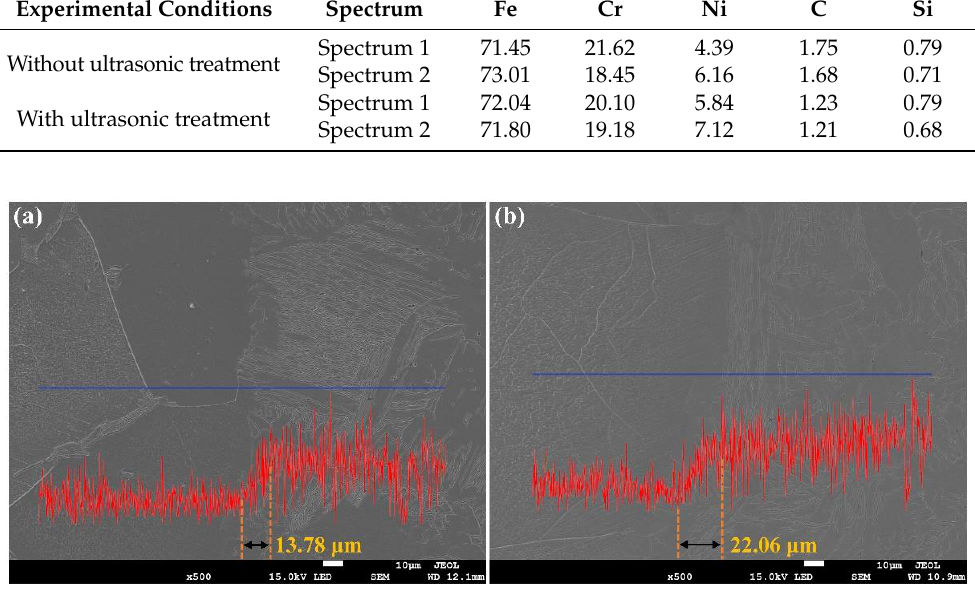
Figure 13. EDS linear scanning of the Ni element content in the transition zone between the WM and HAZ: ( a ) without ultrasonic treatment and ( b ) with ultrasonic treatment.